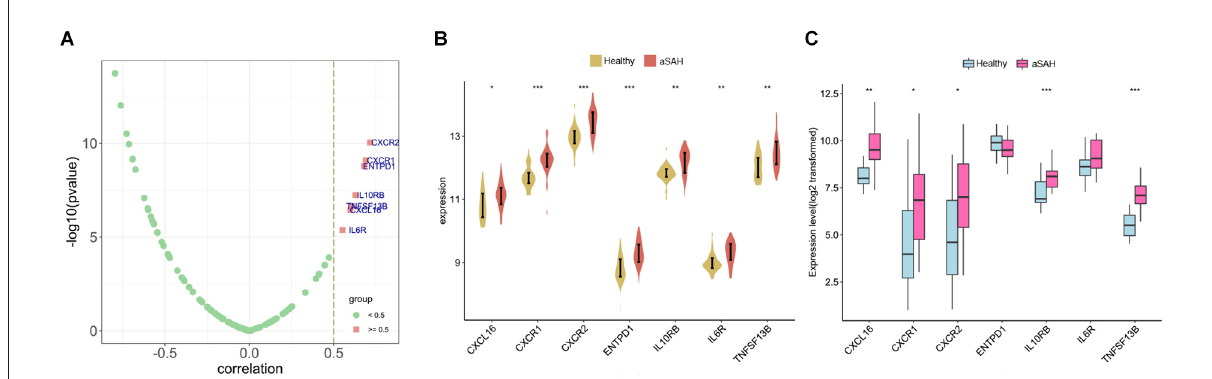
FIGURE11 (A) Correlation of immunomodulators with SRPK1. (B,C) The expression difference of immunomodulators with correlation coefficient more than 0.5 between aSAH and control tissues in the blood and tissue samples (* p < 0.05, ** p < 0.01, *** p <